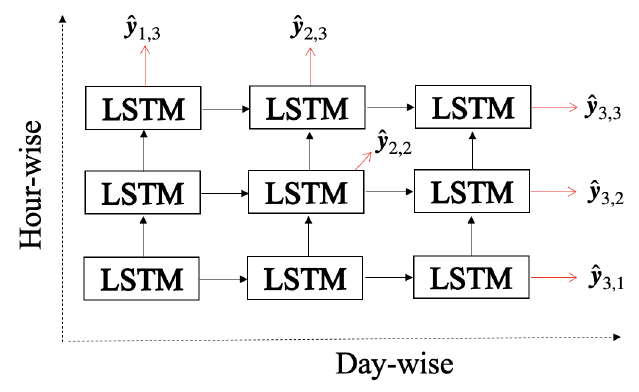
Figure 8. Architecture of the proposed two-dimensional